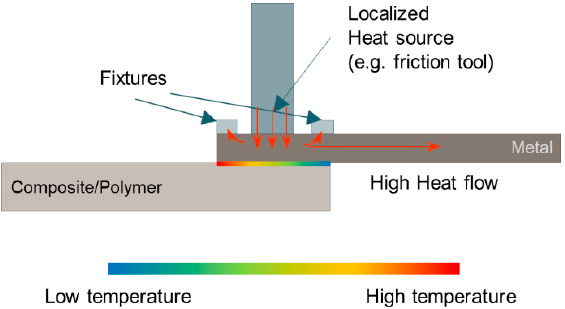
Figure 16. Schematic of uneven temperature distribution produced at the metal-composite interface since the localized heating source, high heat flow in metal, and heat exchanges with fixtures. This leads to uneven joining conditions at the metal-composite interface